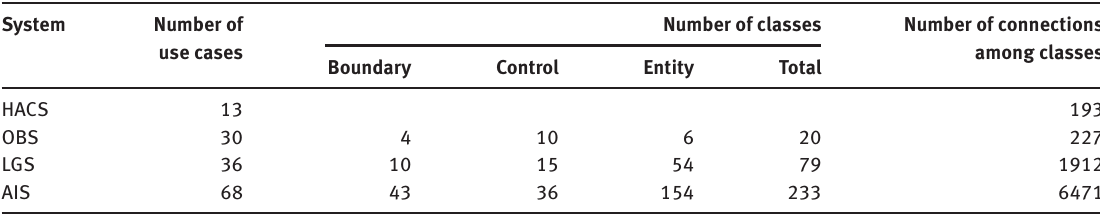
Table 1: Details of the Four Real-World Systems as Case